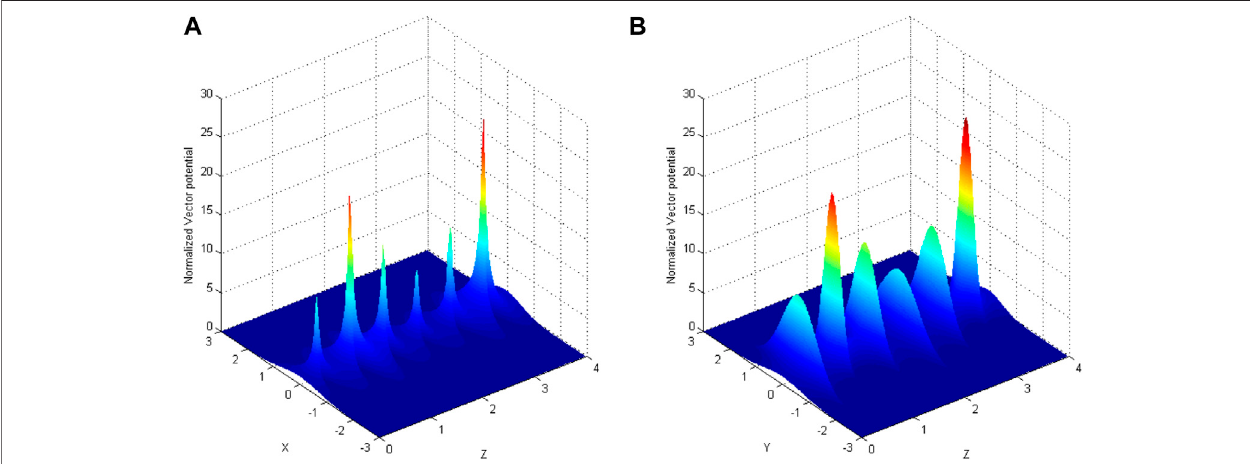
FIGURE 15 | DAW normalized vector potential in the presence of magnetic islands as well as perturbation in the density in the (A) x – z plane ( fi xed y) and (B) y – z plane ( fi xed x) obtained using a semi-analytical model. “ Reproduced from [(Sharma et al., 2020), Physics of Plasmas , 27 , https://doi.org/10.1063/1.5142893], with the permission of AIP Publishing.